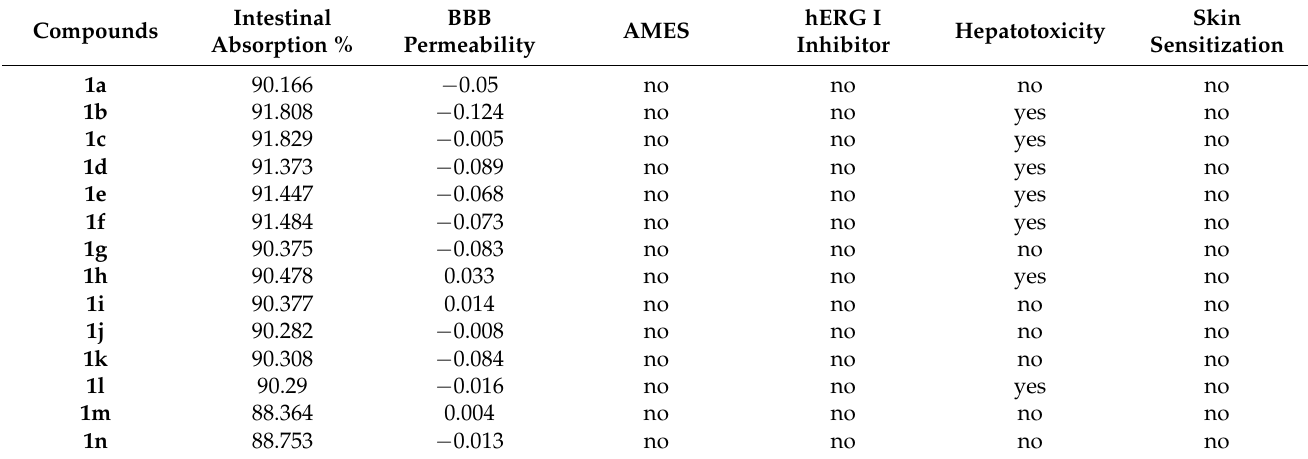
Table 6. Computational pharmacokinetic and toxicity profiles for compounds.